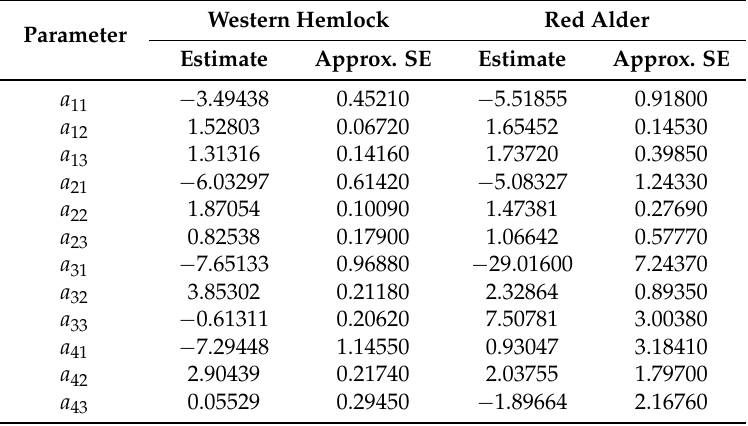
Table 2. Parameter estimates and their approximate standard errors (SE) for the component and total aboveground biomass models for red alder and Western hemlock trees. Model forms for component and total aboveground biomass (AGB) are given in Equations